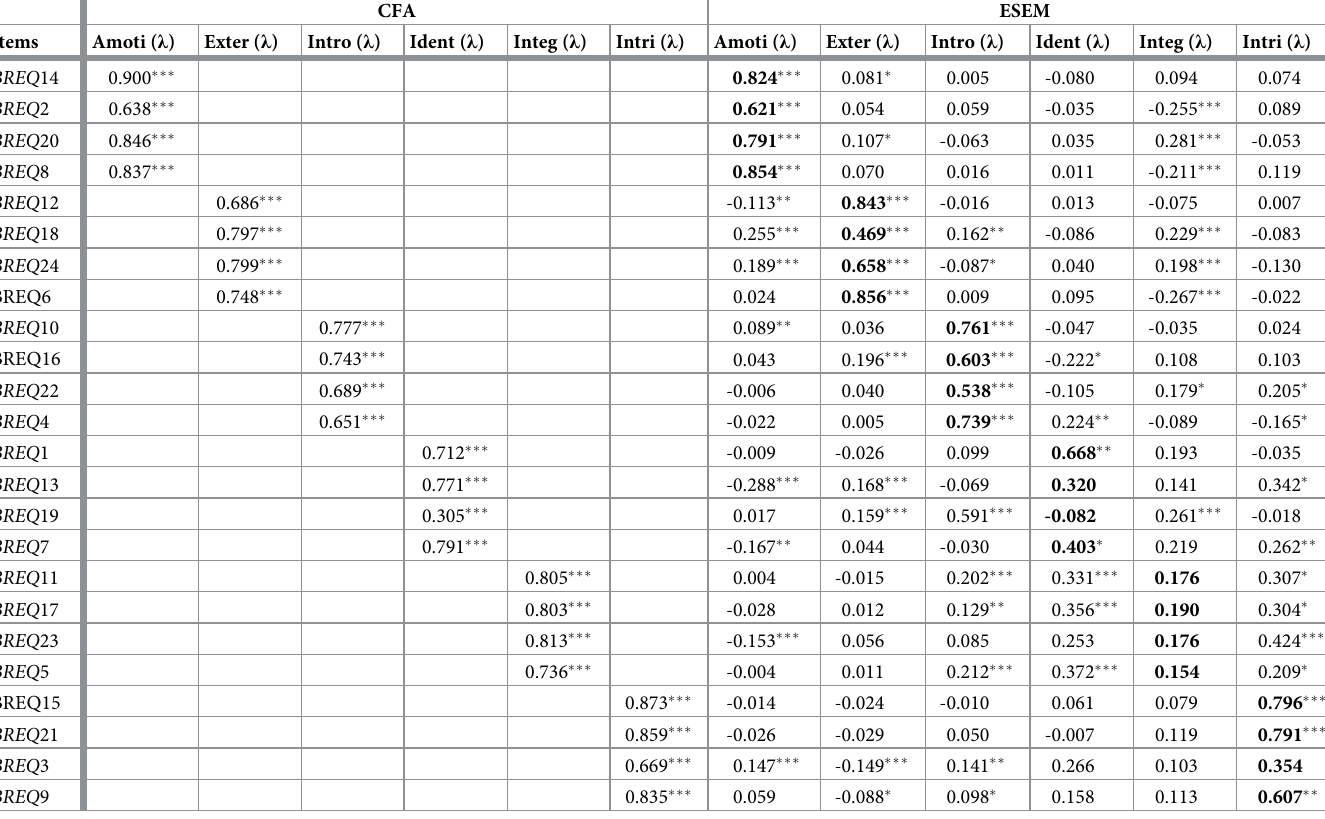
Table 3. Standardized factor loadings for confirmatory factor analysis and exploratory structural equation